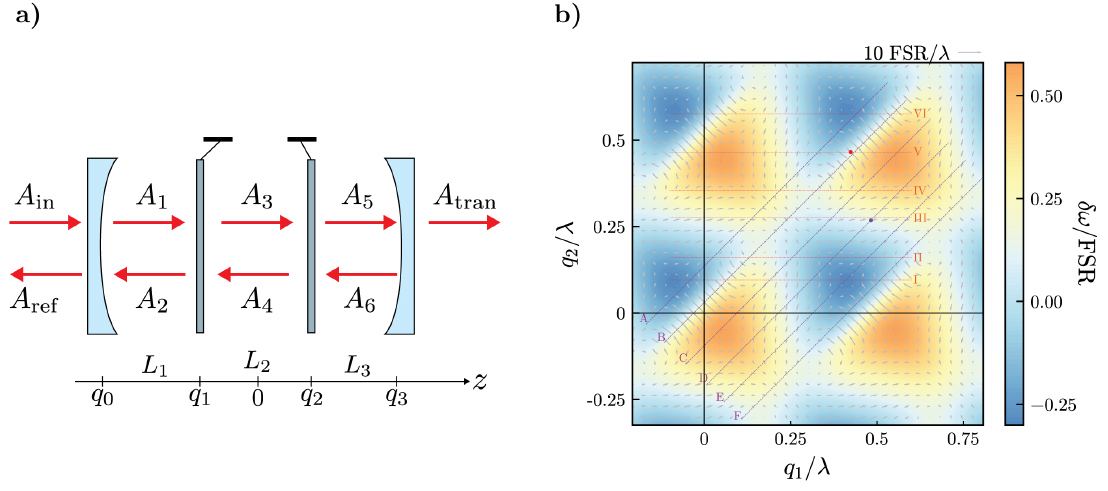
Figure 1. ( a ) Schematic diagram of the system. ( b ) Contour plot of the frequency shift function δω normalized to the free–spectral–range of the cavity, FSR = π c / L , as a function of the membrane positions q 1 and q 2 normalized to the wavelength, due to the presence of the two–membrane cavity. The parameters used for the numerical analysis are: λ = 1064 nm, R = 0.99994, L = 90 mm, L m = 104 nm, and n = 2.17. Superimposed the vector plot of the gradient field of the frequency shift, whose components give the two optomechanical couplings, with the unit indicated on the top–right of the panel. The oblique blue lines (A–F) and the horizontal red lines (I–VI) indicate the experimental spectra reported in Figure 3 (A–F). The red and blue dots represent the points where the optomechanical coupling was